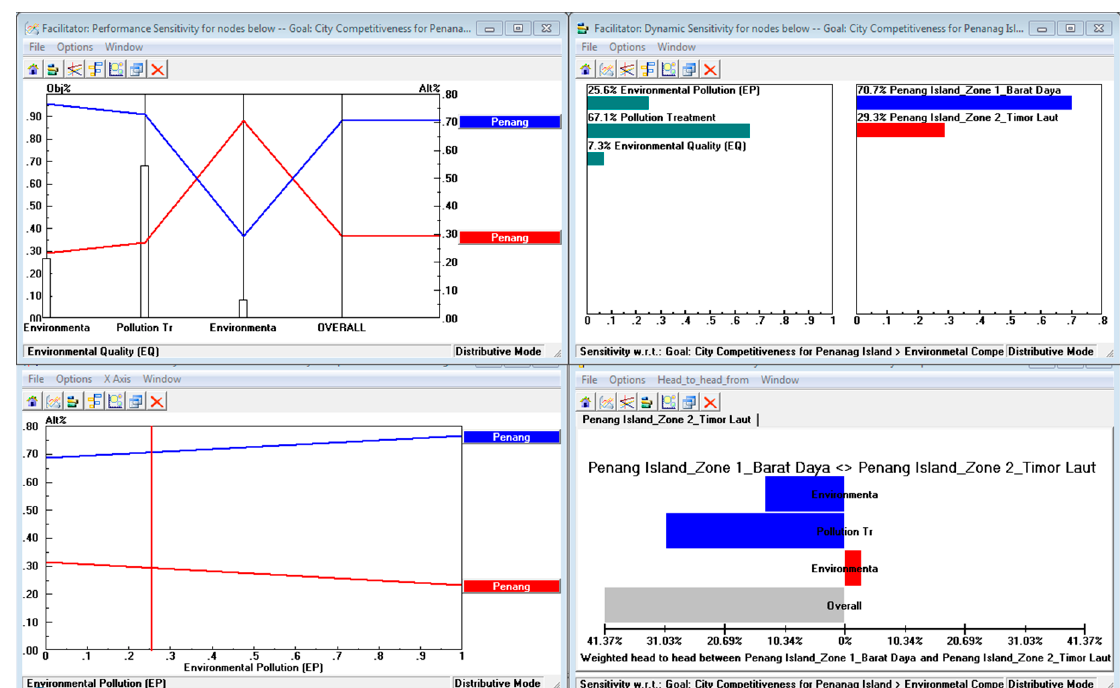
Figure 8. Environmental criteria, subcriteria, and alternative charts for expert decision scoring are dynamic, gradient, head-to-head, and 2D-sensitive.